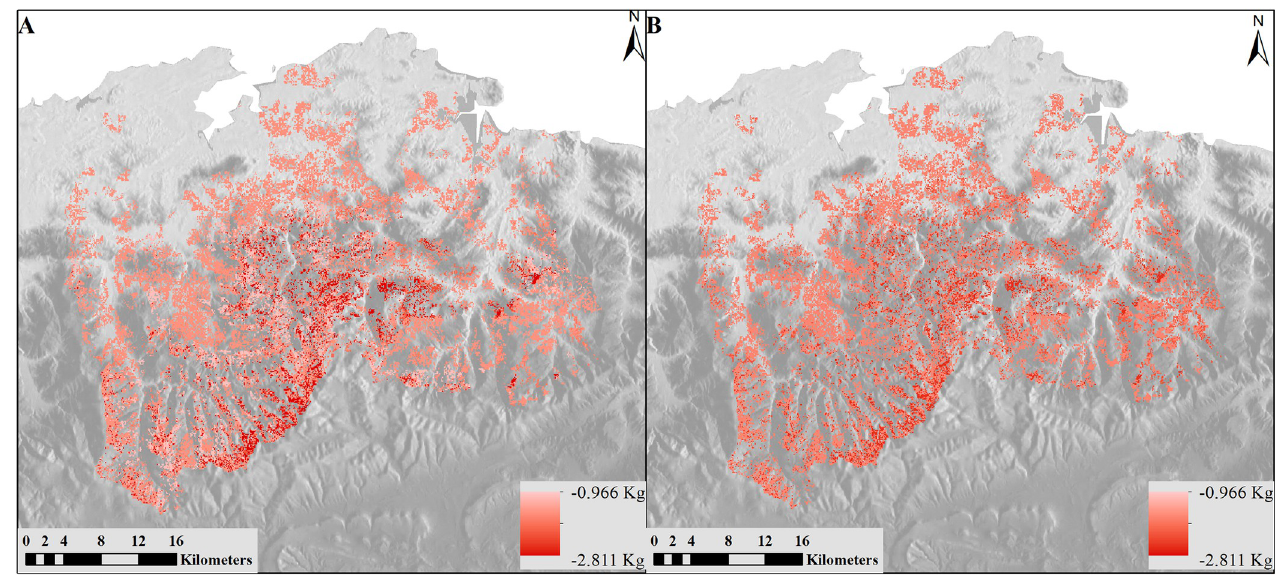
Fig 9. Modelled results of livestock mass variation. (A) Cattle and (B) Mares in kg/day. Reprinted from [67] under a CC BY license, with permission from ISPRS Journal of Photogrammetry and Remote Sensing, original copyright 2014.